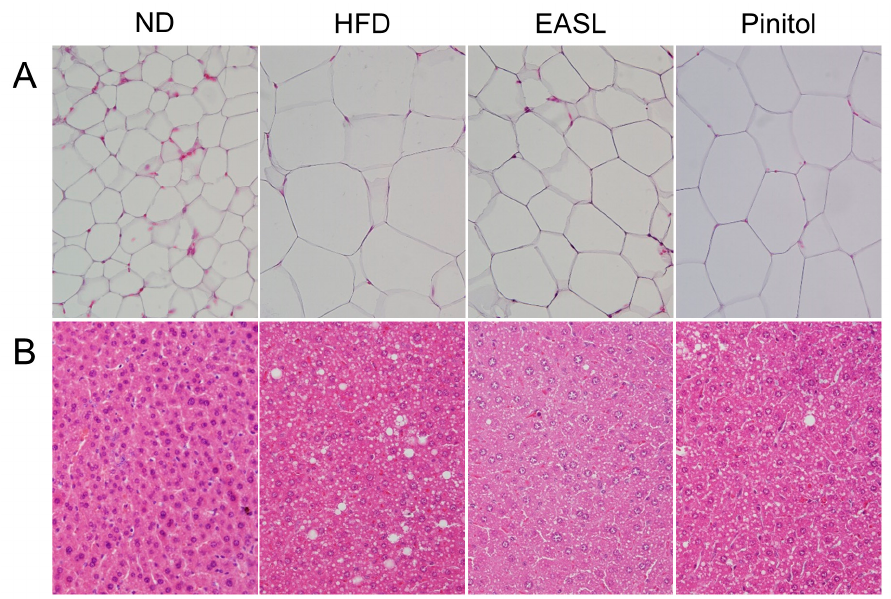
Figure 1. Histology of the white adipose tissue (WAT) ( A ) and liver ( B ) with hematoxylin and eosin (H&E) staining in HFD-fed C57BL/6J mice (400× original